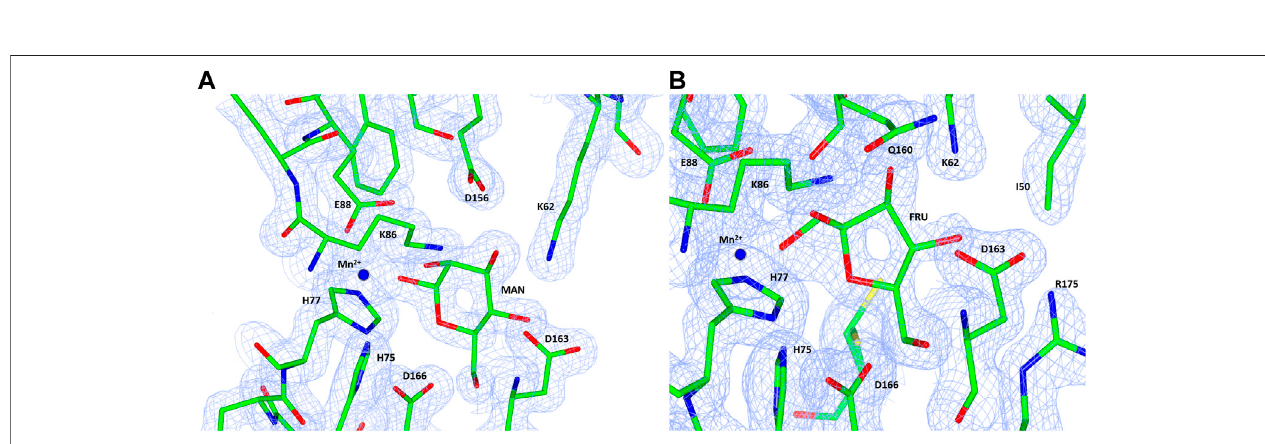
FIGURE 10 | A diagram showing the electron density maps in the region of the mannose (A) and fructose (B) binding to TsLI. The 2Fo — Fc (blue) is contoured at 1.3 σ . The ligand and amino acid residues are shown as stick models and the manganese ion is shown as a blue